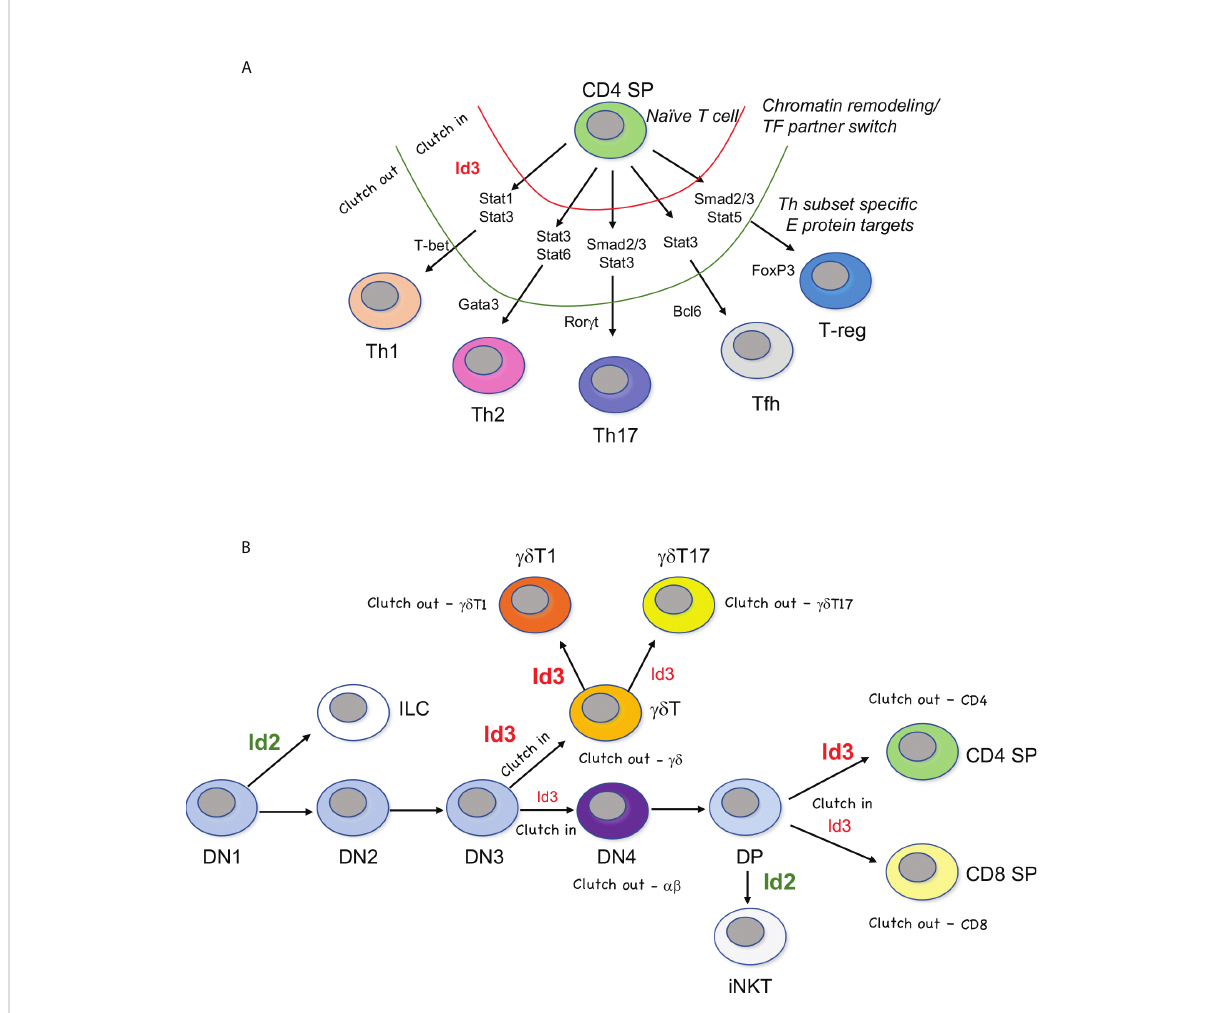
FIGURE 1 “ Clutch ” model of Id3-E protein mediated fate choice. (A) E proteins regulate a core CD4 T cell program in naïve T cells. Upregulation of Id3 causes a transient inhibition of E protein activity (red, clutch in), during which time initiating transcription factors provide access to Th subset- speci fi c genes. Once remodeling is fi nished, Id3 activity ceases and E protein activity resumes (green, clutch out). E proteins can then induce master regulators and effector genes speci fi c to each Th lineage. (B) Waves of graded Id3 (red) induction in response to TCR signaling pauses a subset E protein activity (clutch in) followed by reassembly of E proteins at successive stages of T cell development (clutch out). Levels of Id3 dictate lineage choice, but E proteins are often engaged in both choices downstream of lineage commitment. Id2 (green) is responsible for differentiation away from the adaptive T cell lineage and into the innate lymphoid cell lineage (ILC) or invariant natural killer T (iNKT) cell lineage. DN=double negative CD4-CD8-, DP=double positive CD4+CD8+, gd T1 = IFN g -producing gd T cells, gd T17 = IL-17 producing gd T